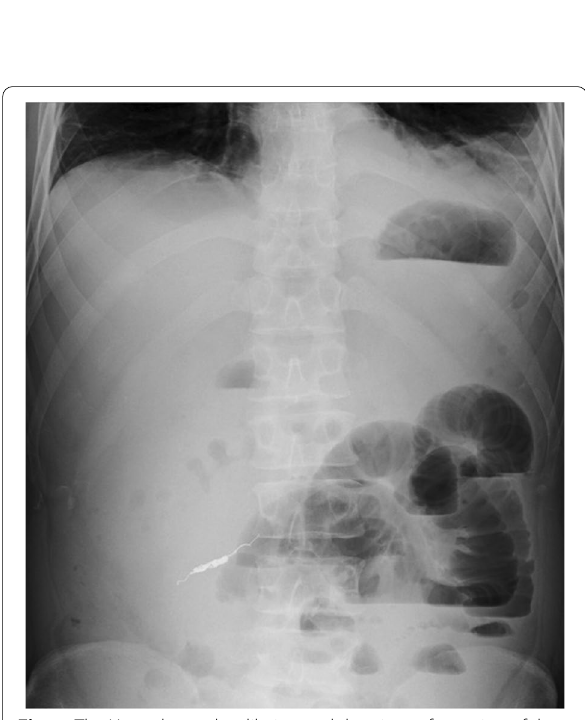
Fig. 4 The X-ray shows the dilation and the niveau formation of the small